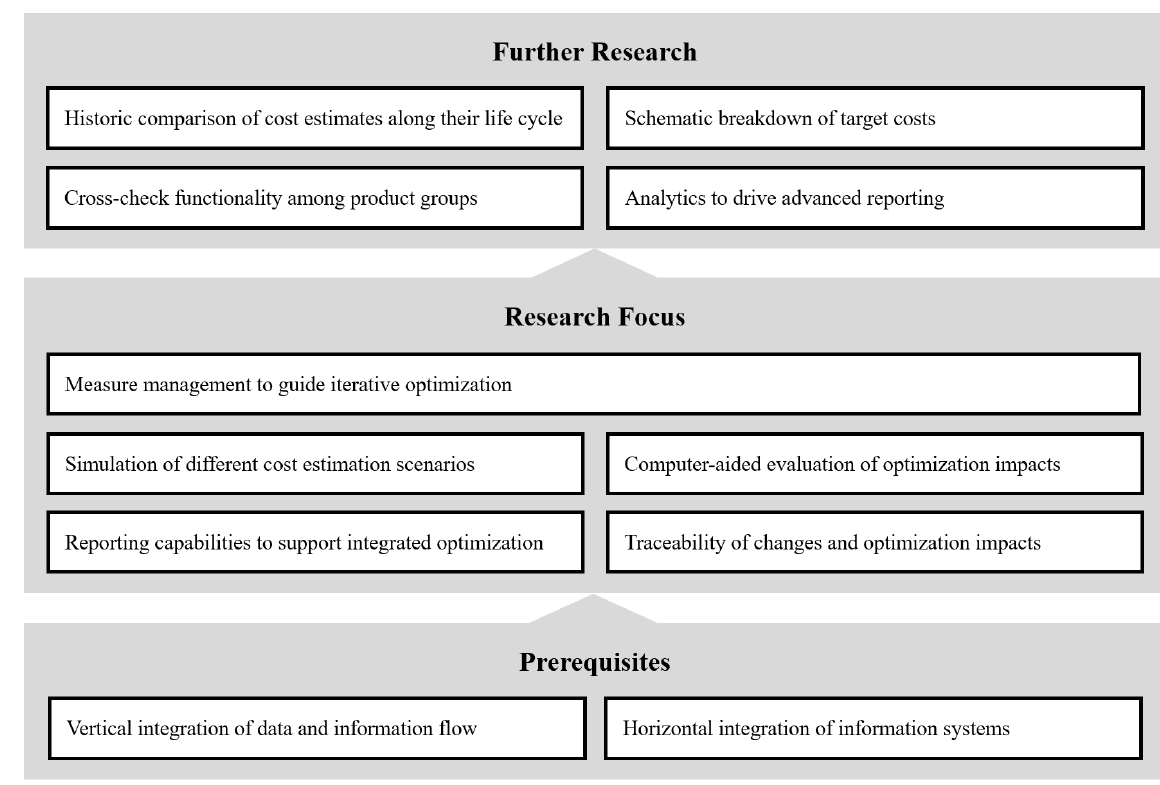
Figure 4. Software requirements for product-cost optimization within product development (adapted from